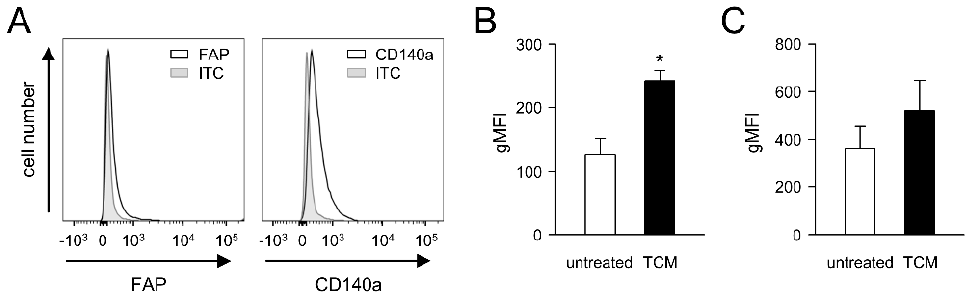
Figure 3. Analysis of tumor-cell-dependent effects on FAP abundance in PAMF. ( A ) Representative histograms of flow cytometry analysis of baseline levels of FAP and CD140a by PAMF. Primary fibroblasts were isolated from skin of female adult A/J mice and cultivated for up to two passages prior to analysis. Cells were then stained with mouse anti-FAP IgG and PE-labeled anti-murine IgG Ab, which served as primary and secondary Ab, respectively (black curve), and with FITC-labeled anti-mouse CD140a Ab or appropriate ITC (grey-filled curve). ( B , C ) Impact of soluble factors secreted by the tumor cells NXS2-HGW on FAP ( B ) and CD140a expression by PAMF ( C ). PAMF were incubated with either TCM (TCM, black columns) or control medium for 48 h (untreated, open columns). Expression levels are presented as gMFI quantified according to the following formula: gMFI of sample—gMFI of ITC. t -test. * p < 0.05.